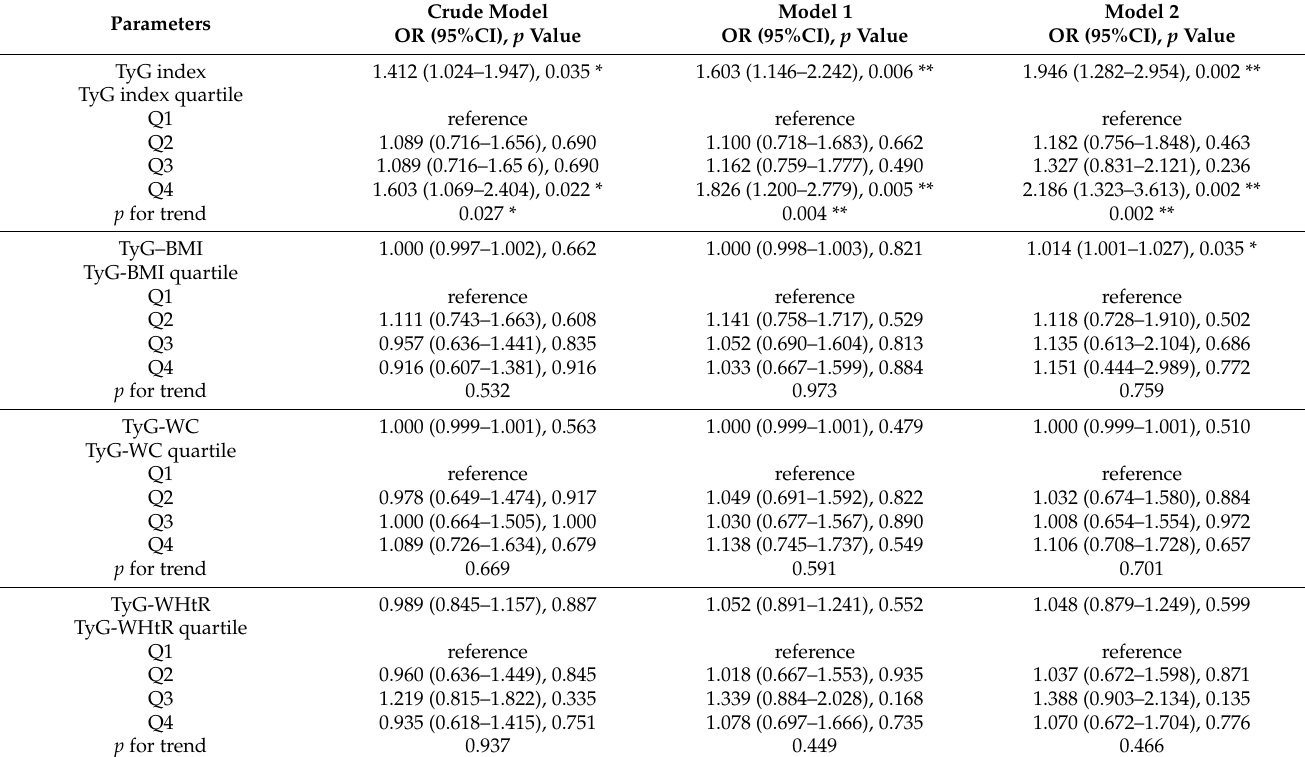
Table 2. Logistic regression analysis for the relationship between various TyG-related parameters and DR in different